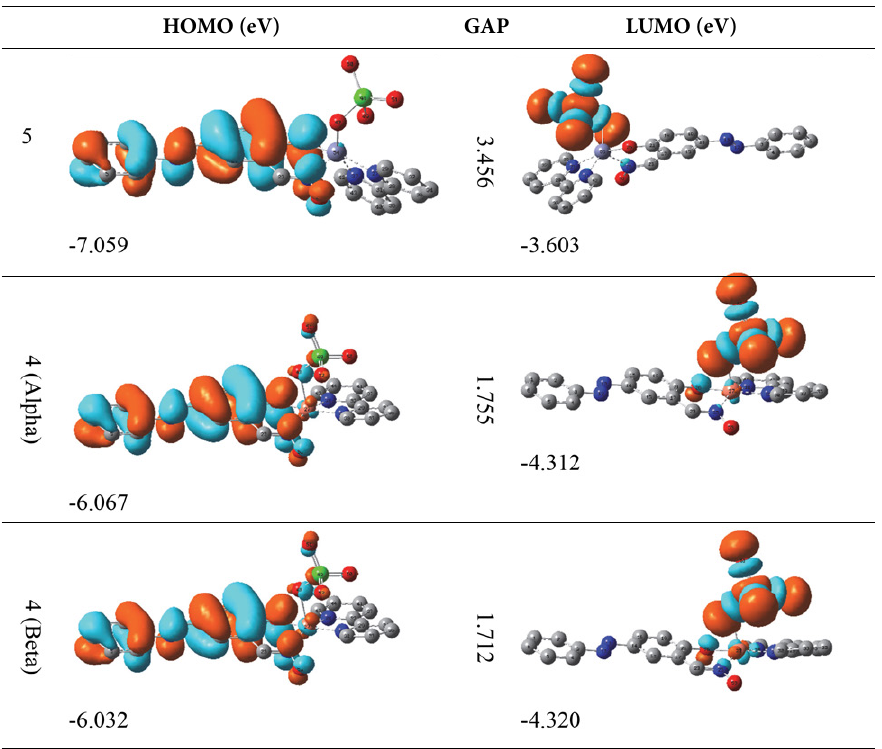
Table 2. The frontier orbitals, energies, and energy gap of complexes in